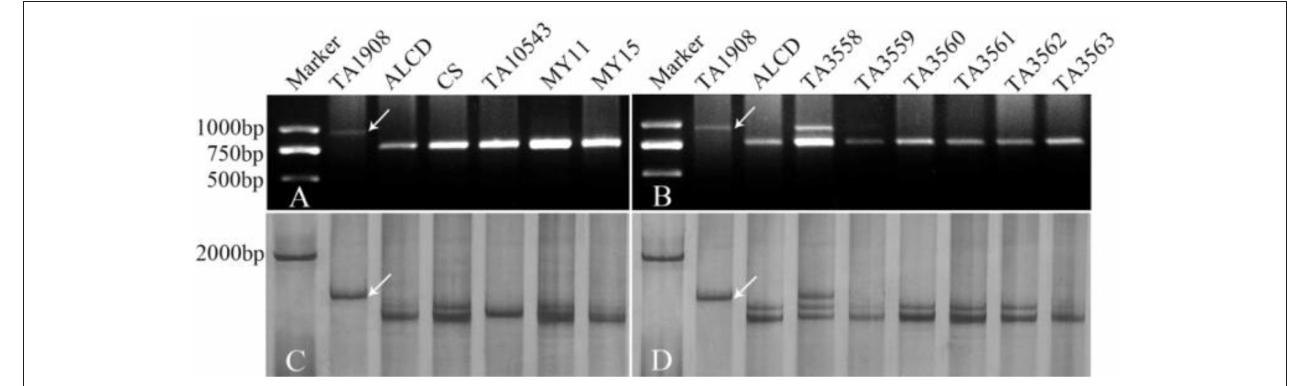
FIGURE 3 | PCR patterns of primer TNAC1497 (A,B) and TNAC1605 (C,D) . Arrows indicate polymorphic bands; Panels A,B are from agarose gel, while C,D are from polyacrylamide gel. TA1908 represents Ae. caudata , while ALCD, CS, MY11, and MY15 mean T. aestivum cv. Alcedo, cv. Chinese Spring, cv. Mianyang11